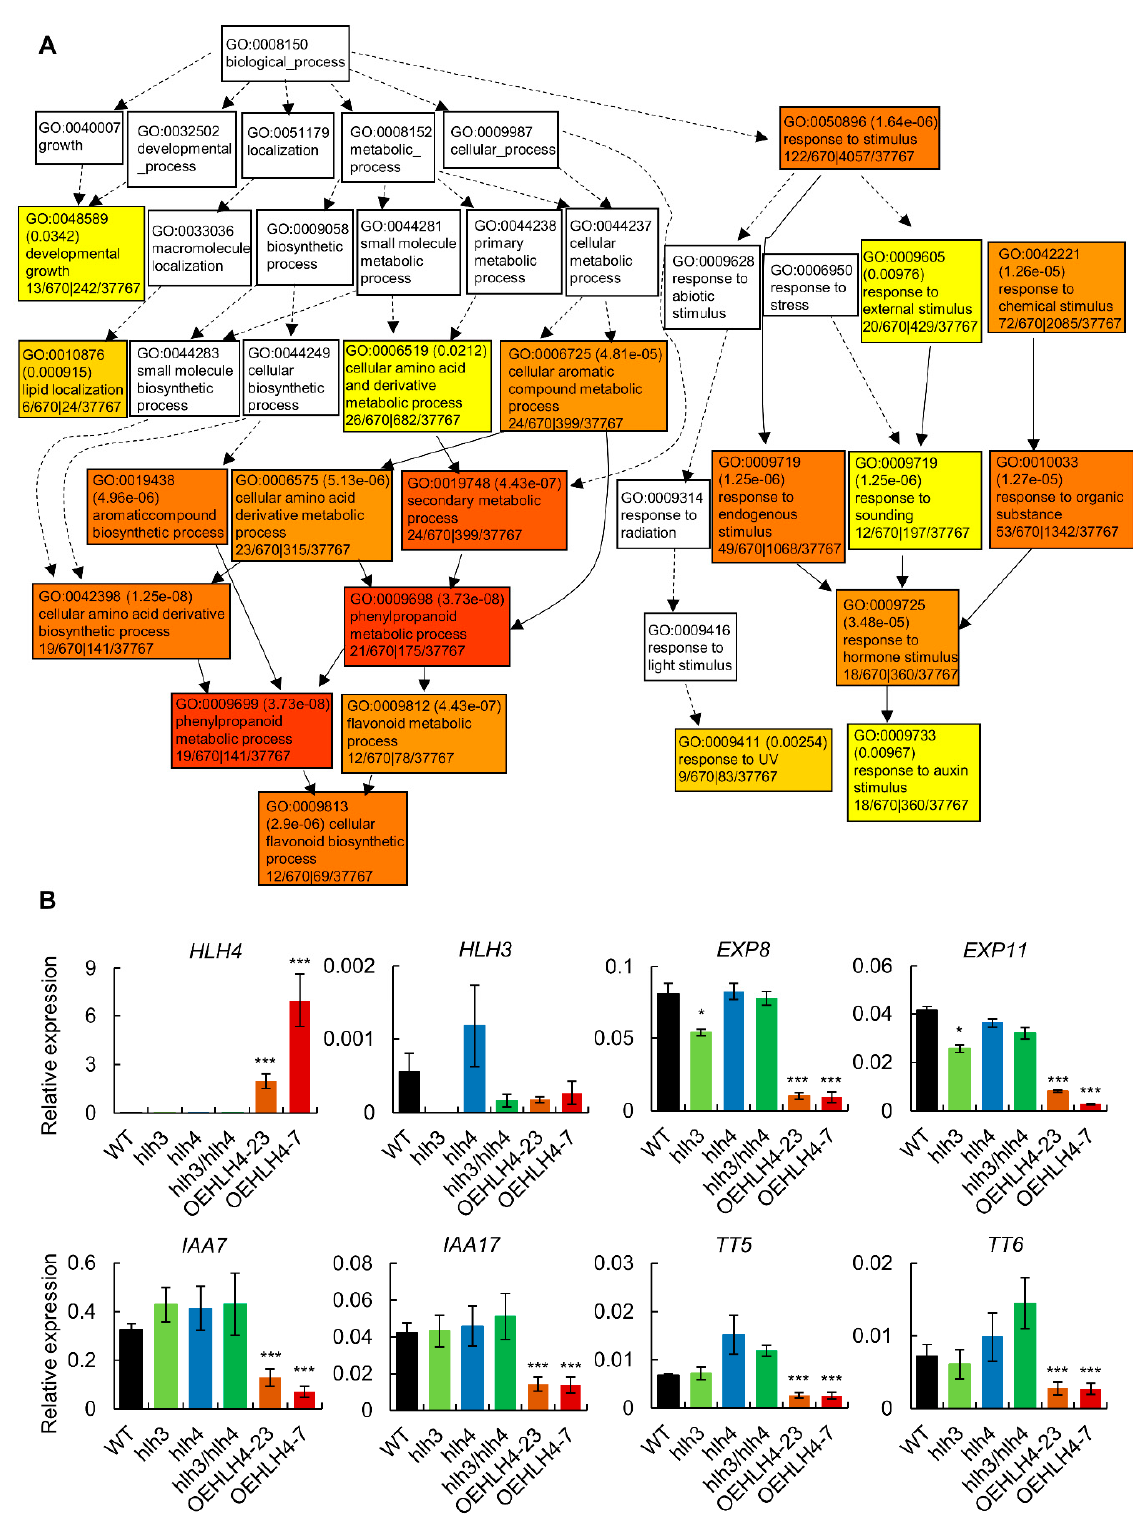
Figure 3. Transcriptomic analyses of RNA-seq Data and RT-qPCR validation. ( A ) Gene ontology enrichment analysis of down-regulated DEGs (differentially expressed genes) in O23 leaves. ( B ) RT- qPCR analysis of selected DEGs. Data represent mean ± SD of three biological replicates with three technical replicates ( n = 9). Asterisks indicate significant differences (* p < 0.05, *** p < 0.001) .